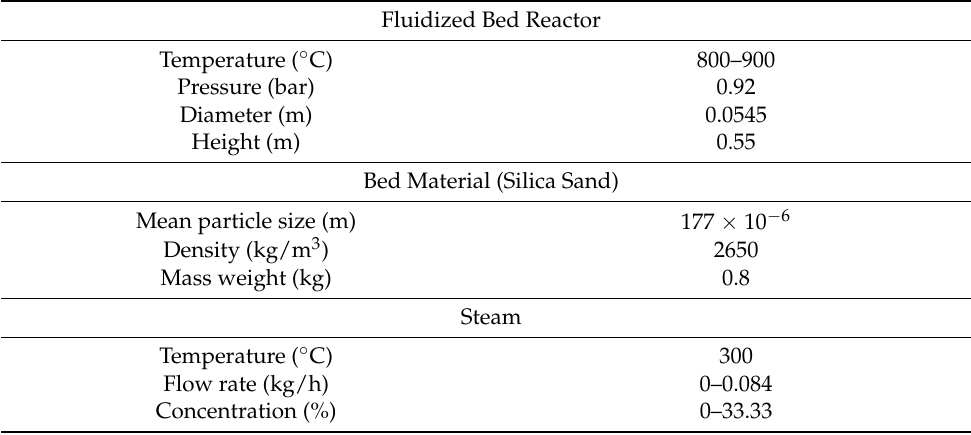
Table 1. Experimental setup parameters used in the simulation.